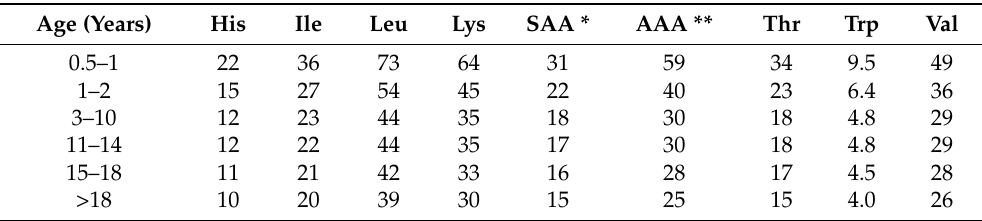
Table 1. Recommended intake of indispensable amino acids (in mg/kg body weight/day) for humans in different age groups (data from [27,30,32]).